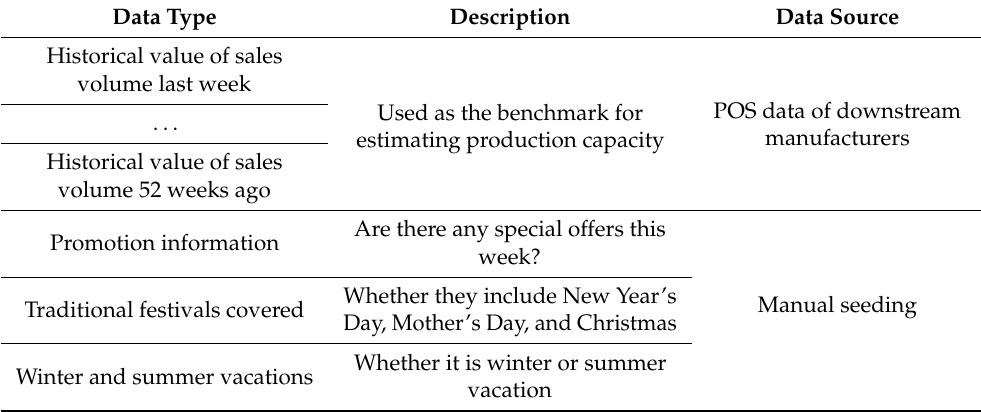
Table 2. Characteristic data for sales